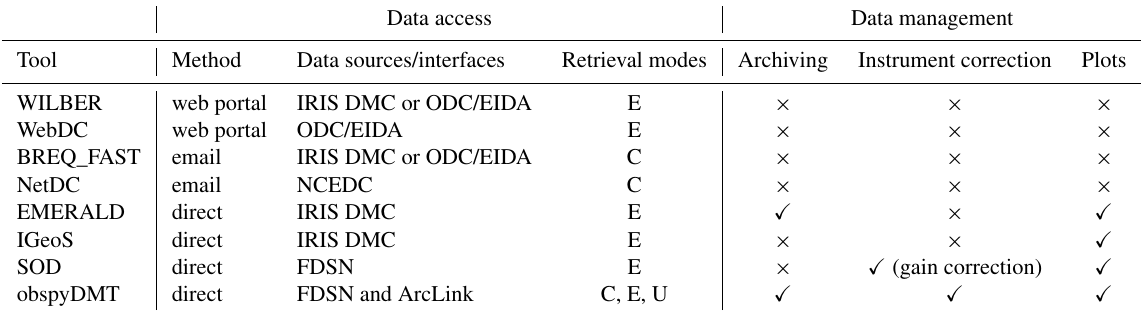
Table 1. Comparison of seismological data retrieval and management tools. Abbreviations: E – event-based; C – continuous time series; U – update mode. ObspyDMT is the only tool to provide access to both FDSN and ArcLink (in a single command), to retrieve both event-based and time-continuous waveform data, and to offer an “update” mode for waveforms, response files and/or metadata information. Few other tools provide for the management of data download and archiving, instrument correction, or diagnostics plots. EIDA: European Integrated Data